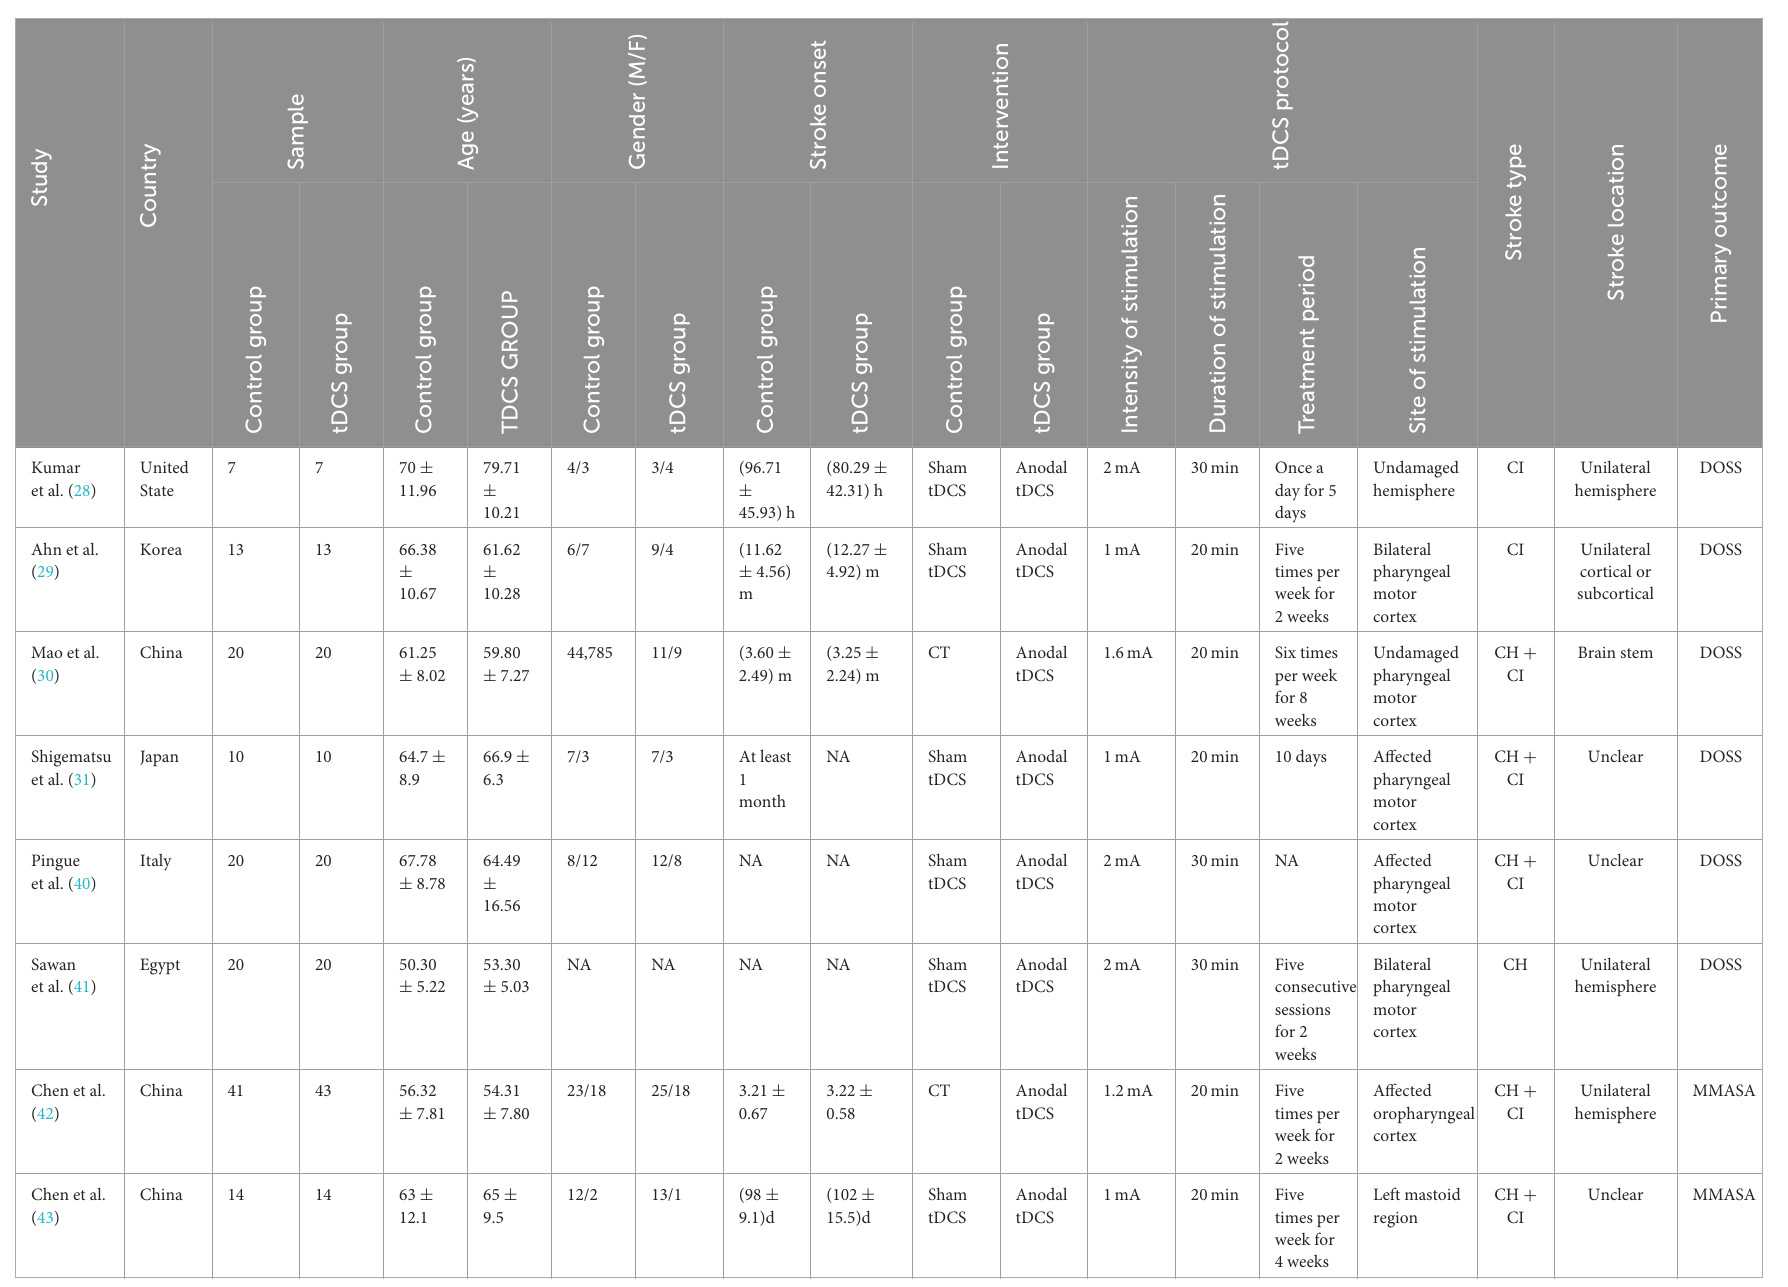
TABLE 1 General characteristics of the included